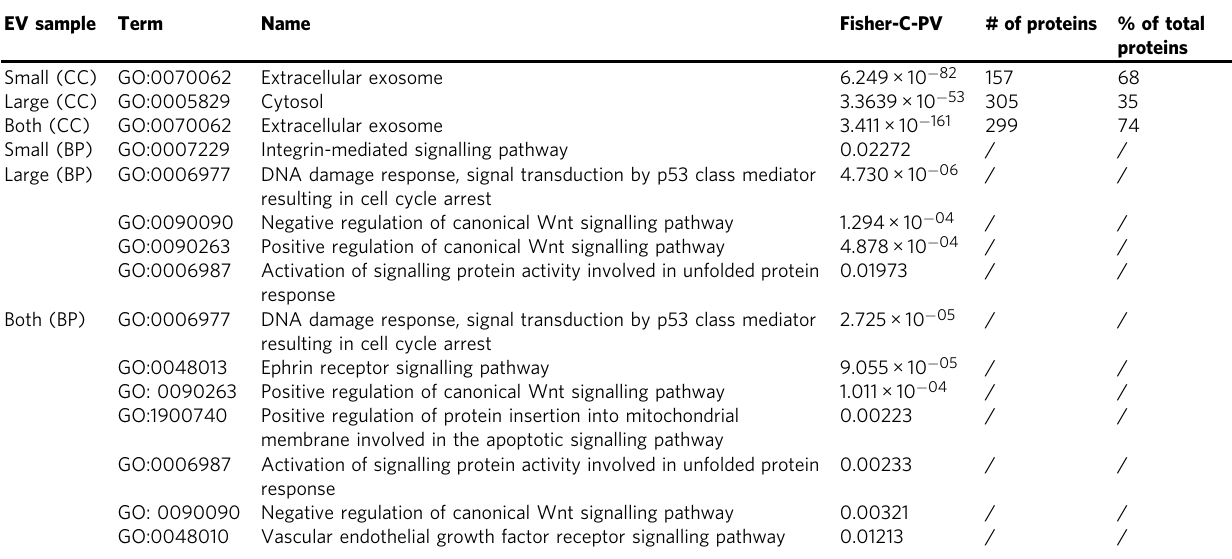
Table 1 Gene ontology enrichment analysis (getgo.russelllab.org) for cellular components (CC) and biological processes (BP) for proteins identi fi ed in smEVs, lgEVs or